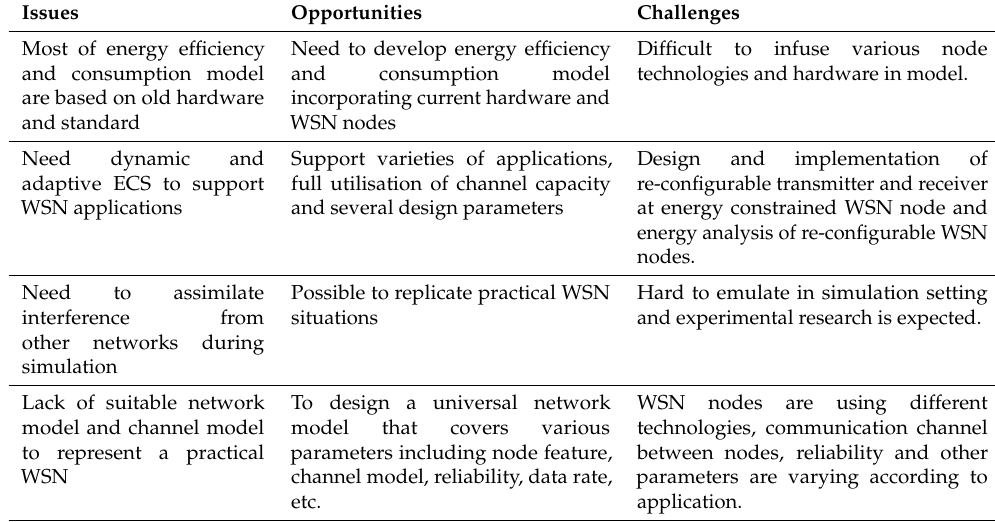
Table 5. A summary of ECS design issues, opportunities and challenges in